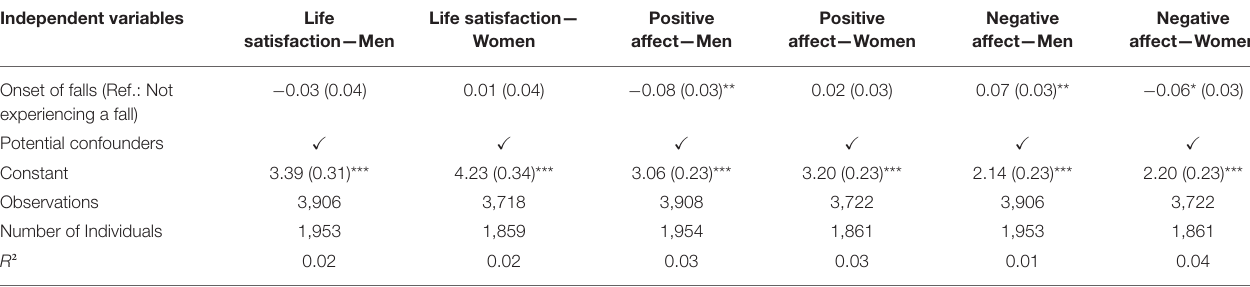
TABLE 2 | Longitudinal association between onset of falls and subjective well-being. Independent variables Life